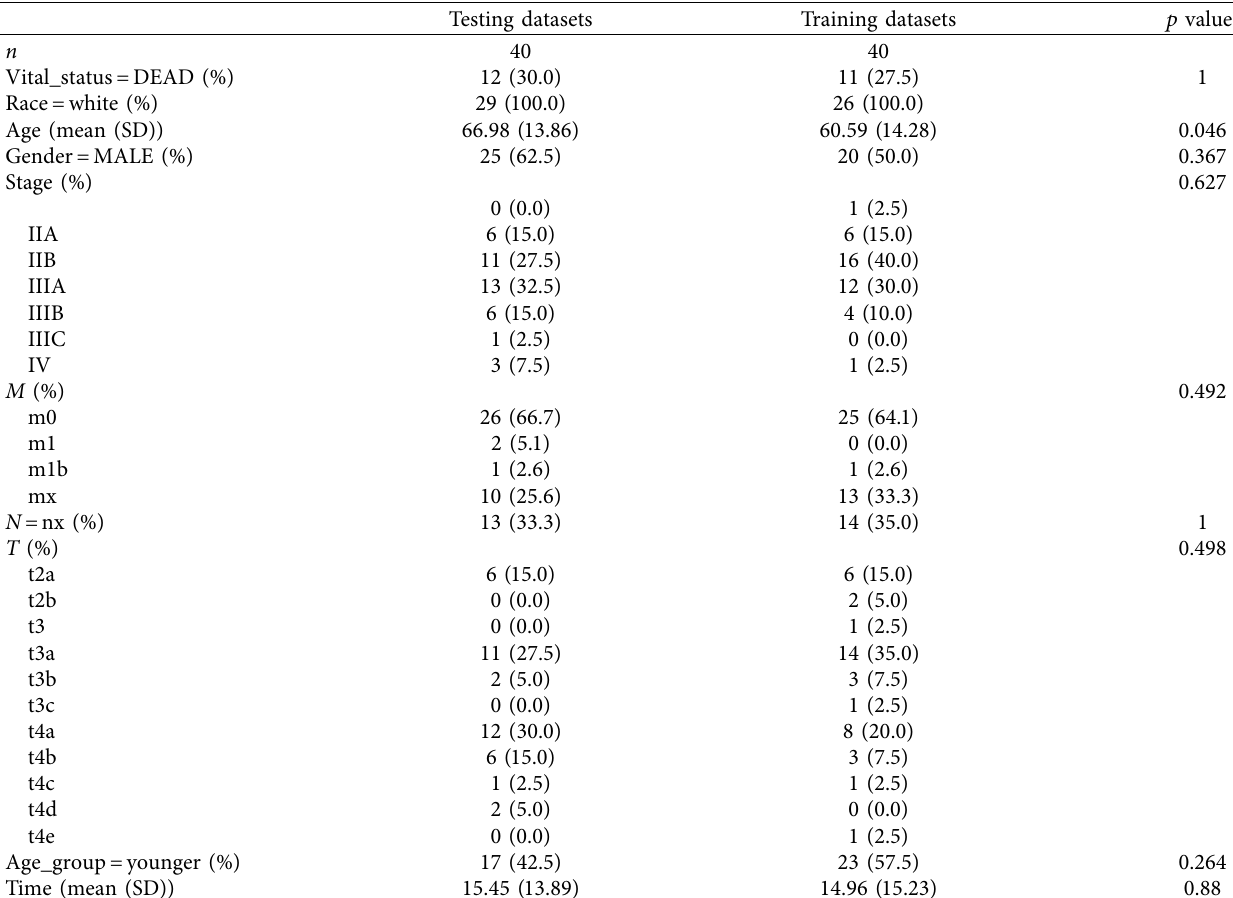
Table 1: Clinicopathological characteristics of training and testing datasets. T : tumor; N : node; M : metastasis; SD: standard